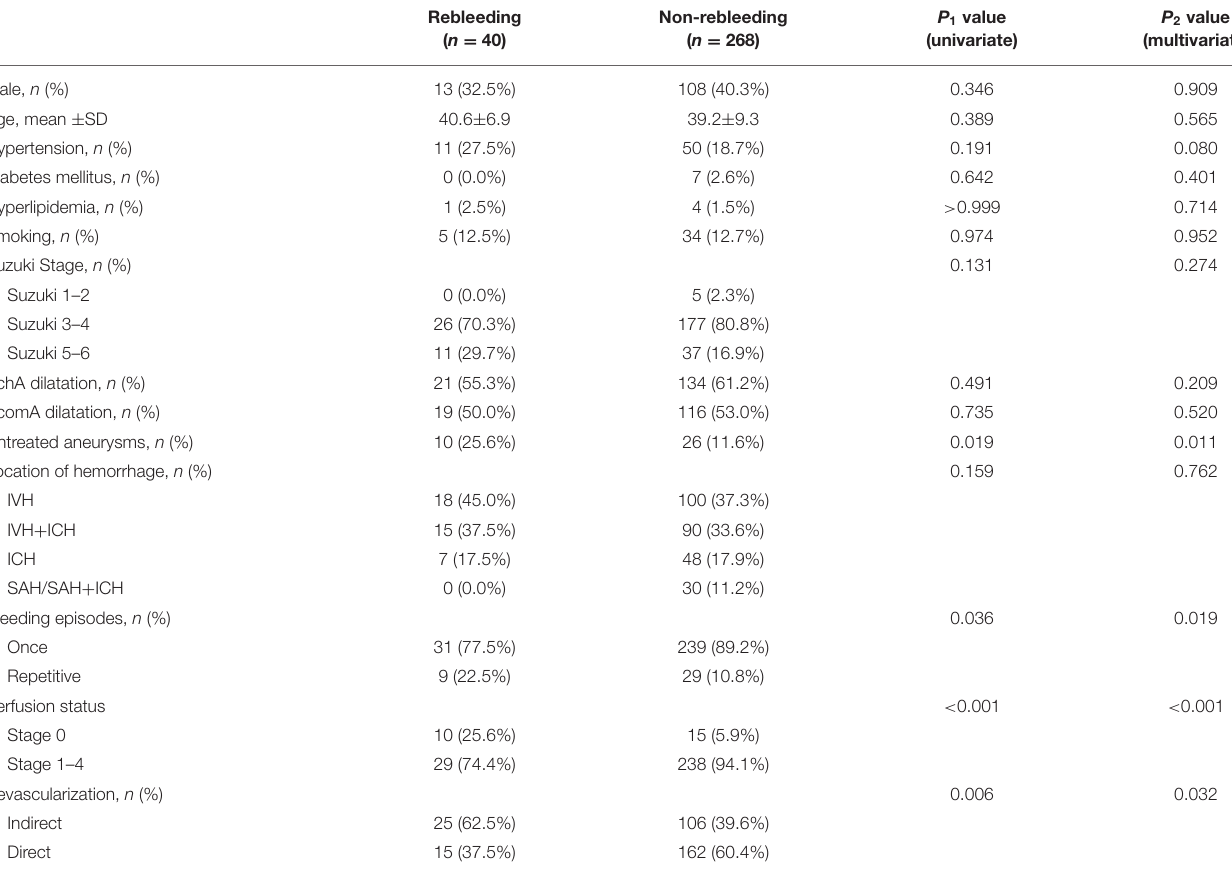
TABLE 4 | Differences in clinical and neuroradiological characterizations between hemispheres with or without rebleeding.